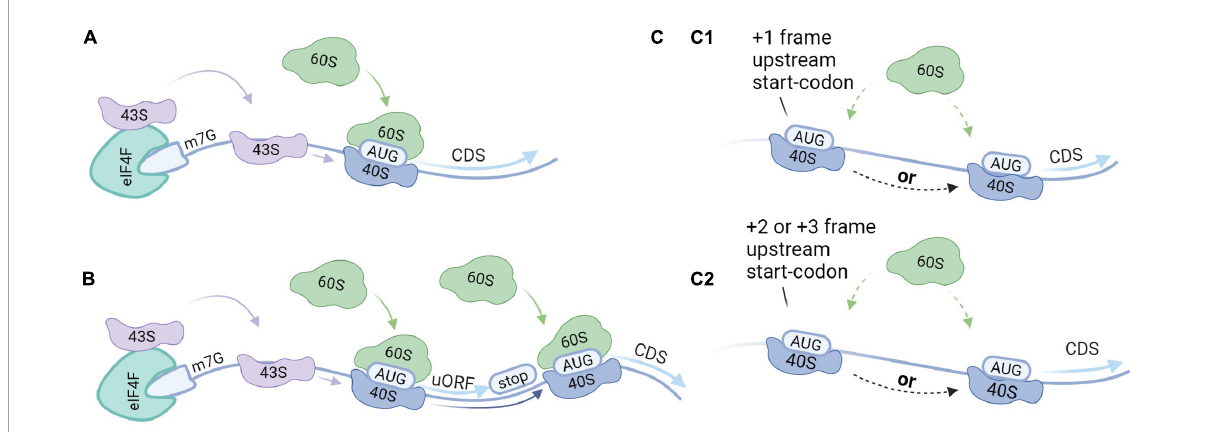
FIGURE3 Translation initiation modes. (A) Canonical cap-dependent translation; the 43S ribosomal subunit is recruited by the 5 (cid:48) end of an messenger RNA (mRNA), and subsequently binds to the mRNA and scans for the AUG start codon. The ribosome is dissociated after the translation of the protein. (B) Translation re-initiation follows the same steps as a cap-dependent translation but after translation of the protein, the 40S ribosomal subunit stays associated with the mRNA. While moving in the 3 (cid:48) direction, the 40S ribosomal subunit can bind initiation factors recovering its initiation potential. As such, translation initiation can take place at a downstream start codon. (C) Leaky scanning; 43S ribosomal subunits can skip potential start codons when they are located in a weak Kozak sequence. (C1) When the start codons are in the same reading frame and there is no stop codon in between, this can result in the translation of two isoforms from the same transcript. Alternatively, when there is a stop codon in between this will result in the translation of two distinct proteins from the same transcript. (C2) When the start codons are out-of-frame two distinct proteins will be translated from the same